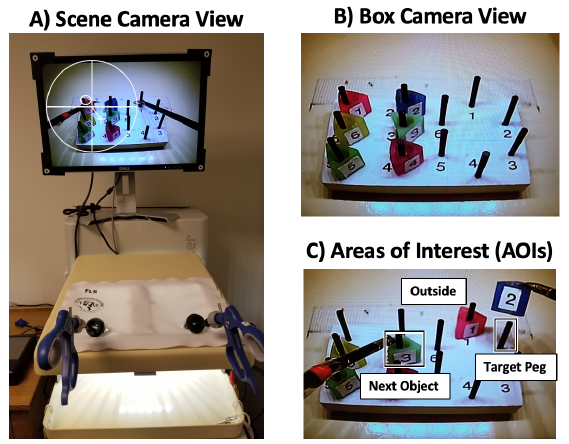
Figure 1. (A) Study apparatus as seen from the scene camera with pupil tracking (large white circle and cross) and gaze location (small white circle), neither of which are visible to the partici- pant. (B) Pegboard as seen from the FLS camera view. (C) Ex- ample areas of interest (AOIs) during the 2 nd transfer of the